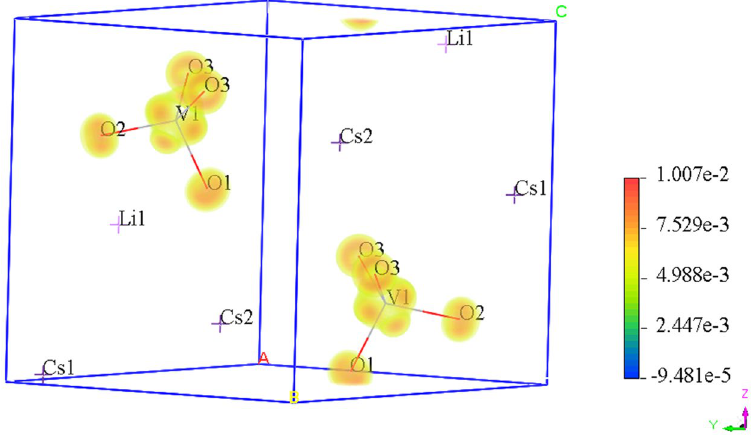
Figure 6. The SHG-density of the virtual-electron process of the largest SHG tensors of CLVO.